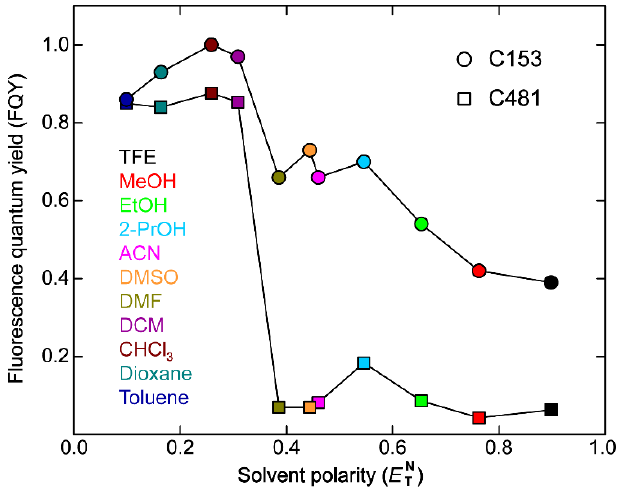
Figure 1. FQY comparison between C481 (squares) and C153 (circles) in various solvents (color- coded) being measured for both chromophores. The notable jump of FQY values from DMF to DCM can be correlated with time-resolved spectral data and insights (see below).